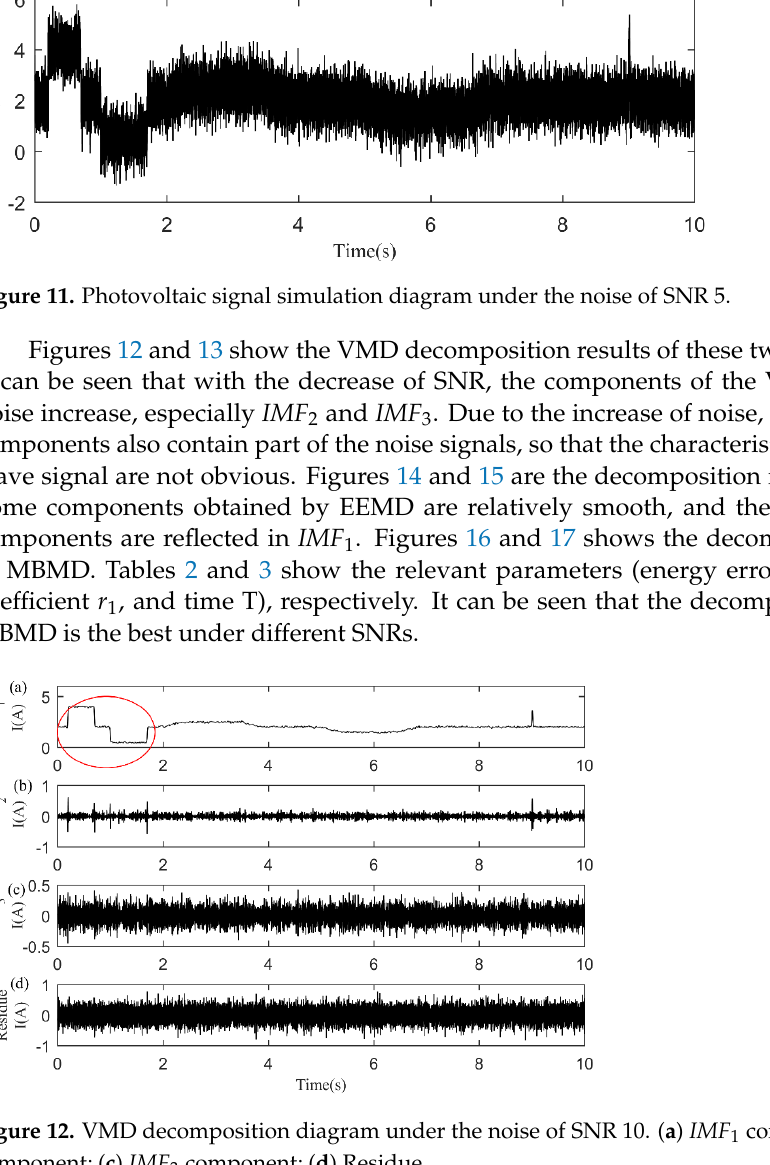
Figure 10. Photovoltaic signal simulation diagram under the noise of SNR 10.